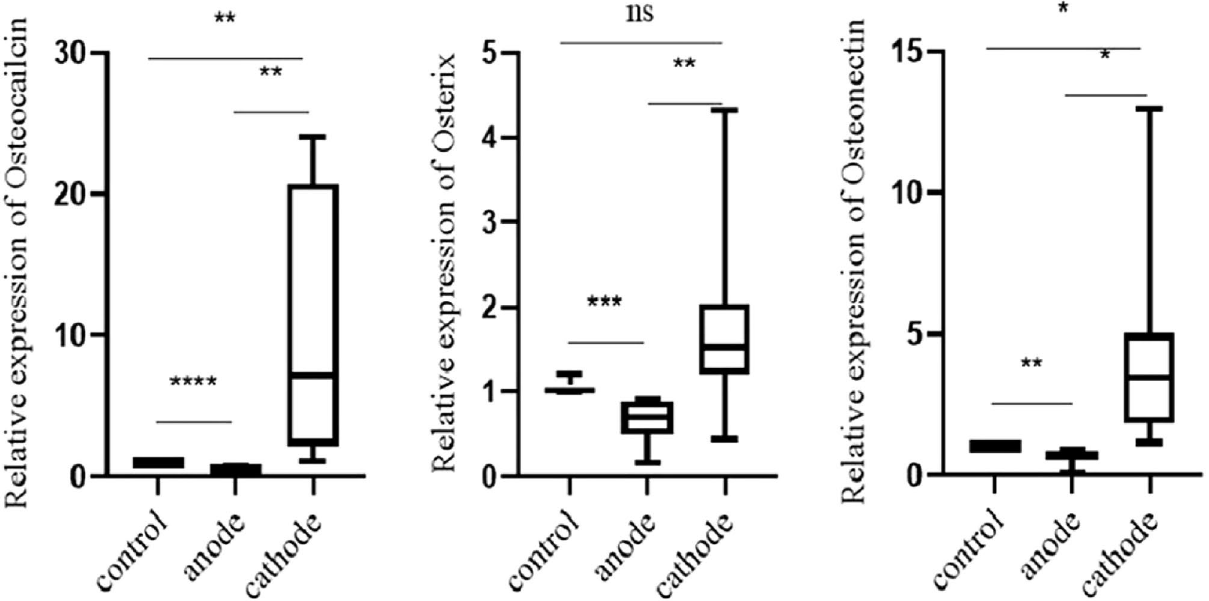
Figure 4. The expression levels of osteocalcin, osterix, and osteonectin in MC3T3-E1 cells of different electrode and control groups were detected by qPCR. ns P > 0.05, *P < 0.05, **P < 0.01, ***P < 0.001, ****P <